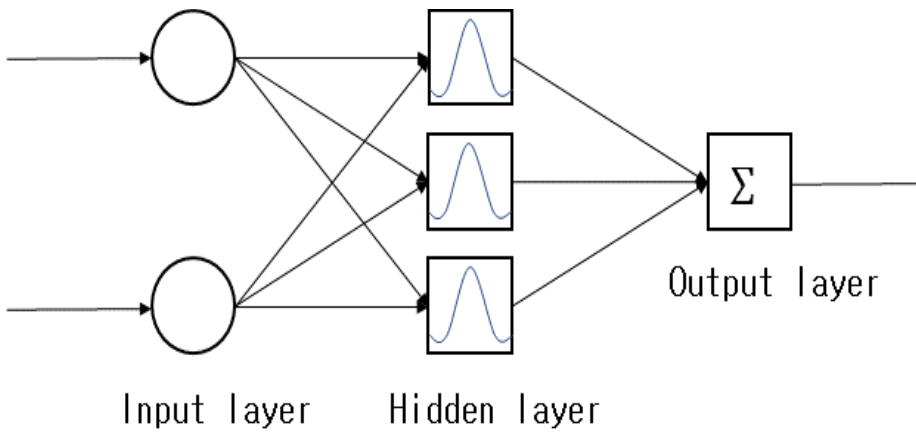
Figure 14. Radial basis function network structure.